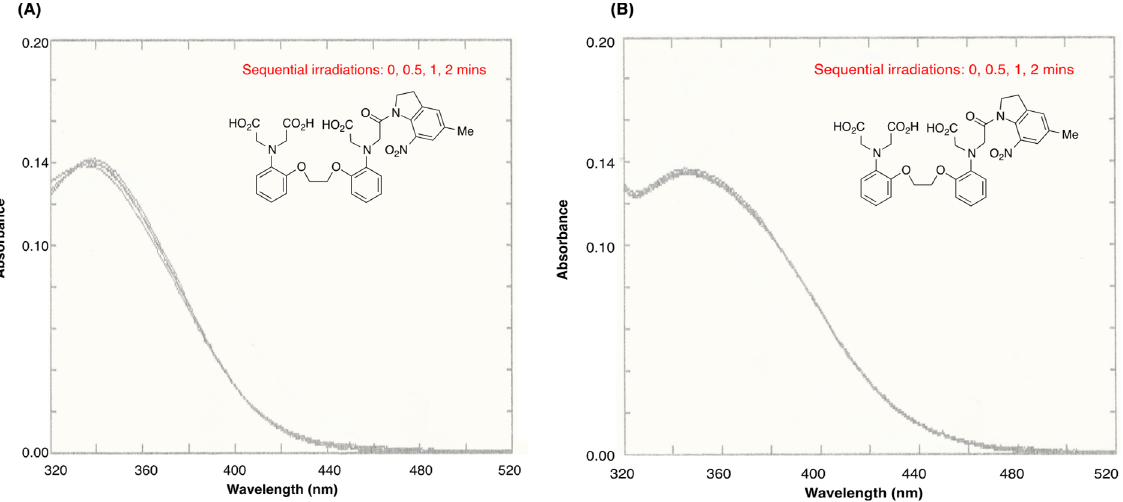
Figure 3. Sequential irradiations of 19 ( A ) in the presence of Ca 2+ and ( B ) in the absence of Ca 2+ . It appears that the photostability of 19 is likely to arise from quenching of the excited state of the nitroindolinyl group by the electron-rich aryl ring(s).We have previously observed an apparently similar quenching in the electron-rich 1-acetyl-4-dimethylamino-7- nitroindoline [24] and efficient formation of a low-lying triplet state in N,N -dimethylamino-4-nitroaniline has been reported elsewhere [25].